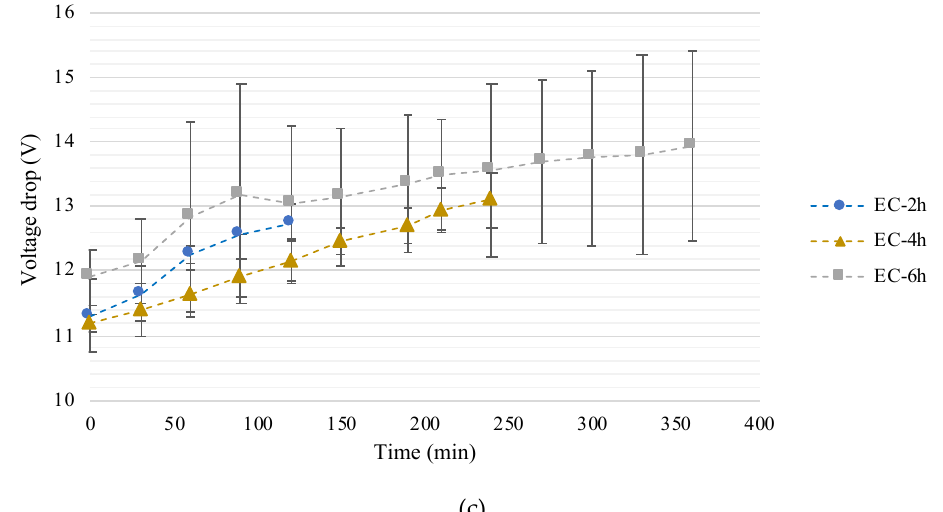
Figure 2. Final effluent ( a ) pH, ( b ) conductivity, and ( c ) voltage drop along the Set 1 experiments. Effluent initial pH and conductivity represented as green dashed line and the standard deviation range represented by the green shadow in ( a ) and ( b ), respectively. In ( a ) to ( c ) standard deviation range represented by the black line; * represents statistical differences in relation to initial effluent value.